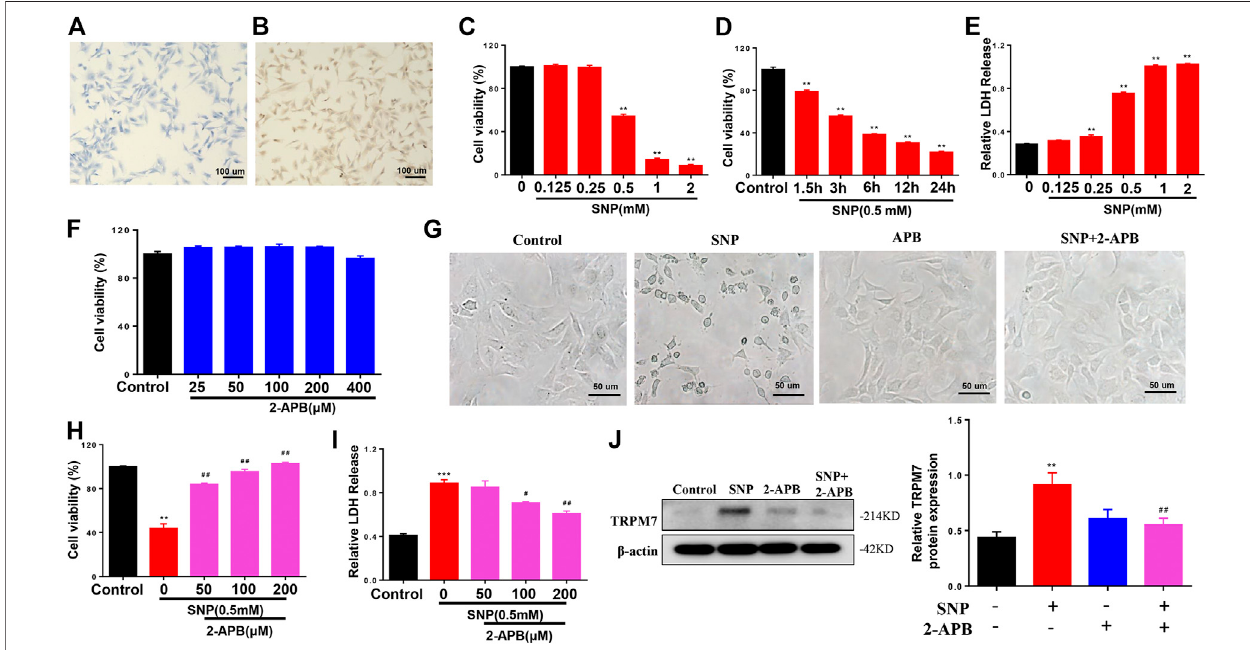
FIGURE 1 | 2-APB increases the viability of SNP-treated chondrocytes (A) Toluidine blue staining for positive identi fi cation of chondrocytes (B) Type II collagen staining for chondrocyte identi fi cation (C) MTT analysis of different concentrations of SNP on chondrocyte viability. Chondrocyte were stimulated by 0.125, 0.25, 0.5, 1.0,2.0 mMSNPfor12 h( n (cid:2) 6) (D) MTTanalysisofdifferenttreatmenttimeofSNPonchondrocyteviability.Chondrocytewerestimulatedby0.5 mMSNPfor1.5,3,6, 12,24 h( n (cid:2) 6) (E) LDHanalysisofdifferentconcentrationsofSNPonchondrocytetoxicity.Chondrocytewerestimulatedby0.125,0.25,0.5,1.0,2.0 mMSNPfor 12 h( n (cid:2) 4) (F) MTTanalysisofdifferentconcentrationsof2-APBonchondrocyteviability.Chondrocytewerestimulatedby25,50,100,200,400 μ M2-APBfor12 h( n (cid:2) 6) (G) Morphology of 2-APB on SNP-treated chondrocytes (H) MTT analysis of 2-APB on viability of SNP-treated chondrocytes. Chondrocytes were treated with 0.5 mM SNP and 50, 100, 200 μ M 2-APB for 12 h ( n (cid:2) 3) (I) LDH analysis of 2-APB on chondrocyte toxicity induced by SNP. Chondrocytes were treated with 0.5 mMSNP and 50, 100, 200 μ M2-APB for 12 h (n (cid:2) 4). (J) Western blot analysis of 2-APB on SNP-induced TRPM7 protein expression in chondrocytes.